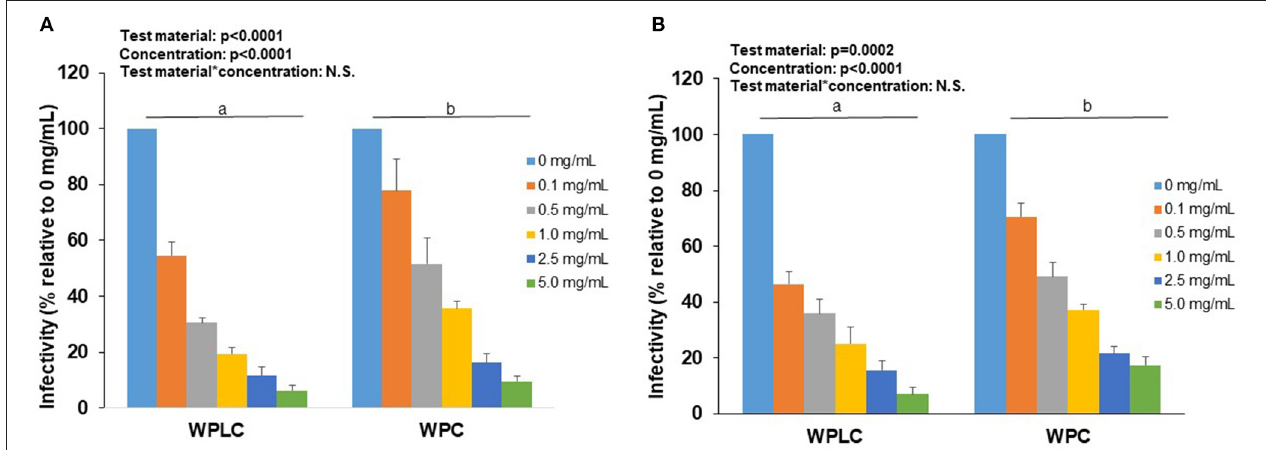
FIGURE 3 | Concentration-dependent reduction of porcine RV OSU (A) or human RV Wa (B) strains infectivity in Caco-2 cells by WPLC and WPC. Data are represented as means ± SEM of 2–3 separate experiments. Infectivity was calculated as % of FFU at each concentration relative to FFU counted in cells infected with RV alone (0 mg/mL). Statistical analysis assessed test material, concentration and test material*concentration effects. Unlike letters represent significant differences ( p < 0.05) between WPLC and WPC. RV, rotavirus; WPC, whey protein concentrate; WPLC, whey protein lipid concentrate.